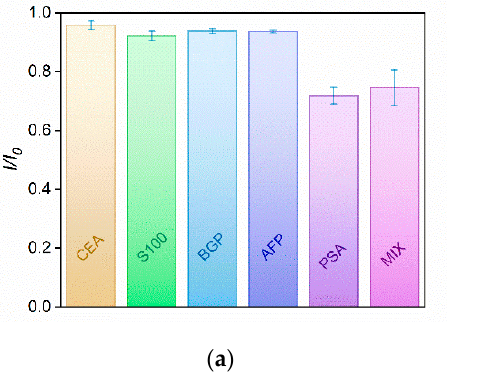
Figure 7. ( a ) Relative ratio of peak current before ( I 0 ) and after ( I ) incubation with different proteins or their mixture c. The concentration of PSA and other proteins was 1 and 10 ng mL − 1 , respectively. Error bars represent the standard deviation of three measurements. ( b ) Relative ratio of peak currents before ( I 0 ) and after ( I ) storing the immunosensor at 4 °C for different times. The peak currents were obtained after the immunosensors bound with 1 ng mL − 1 of CEA. Error bars represent the standard deviation of three measurements.